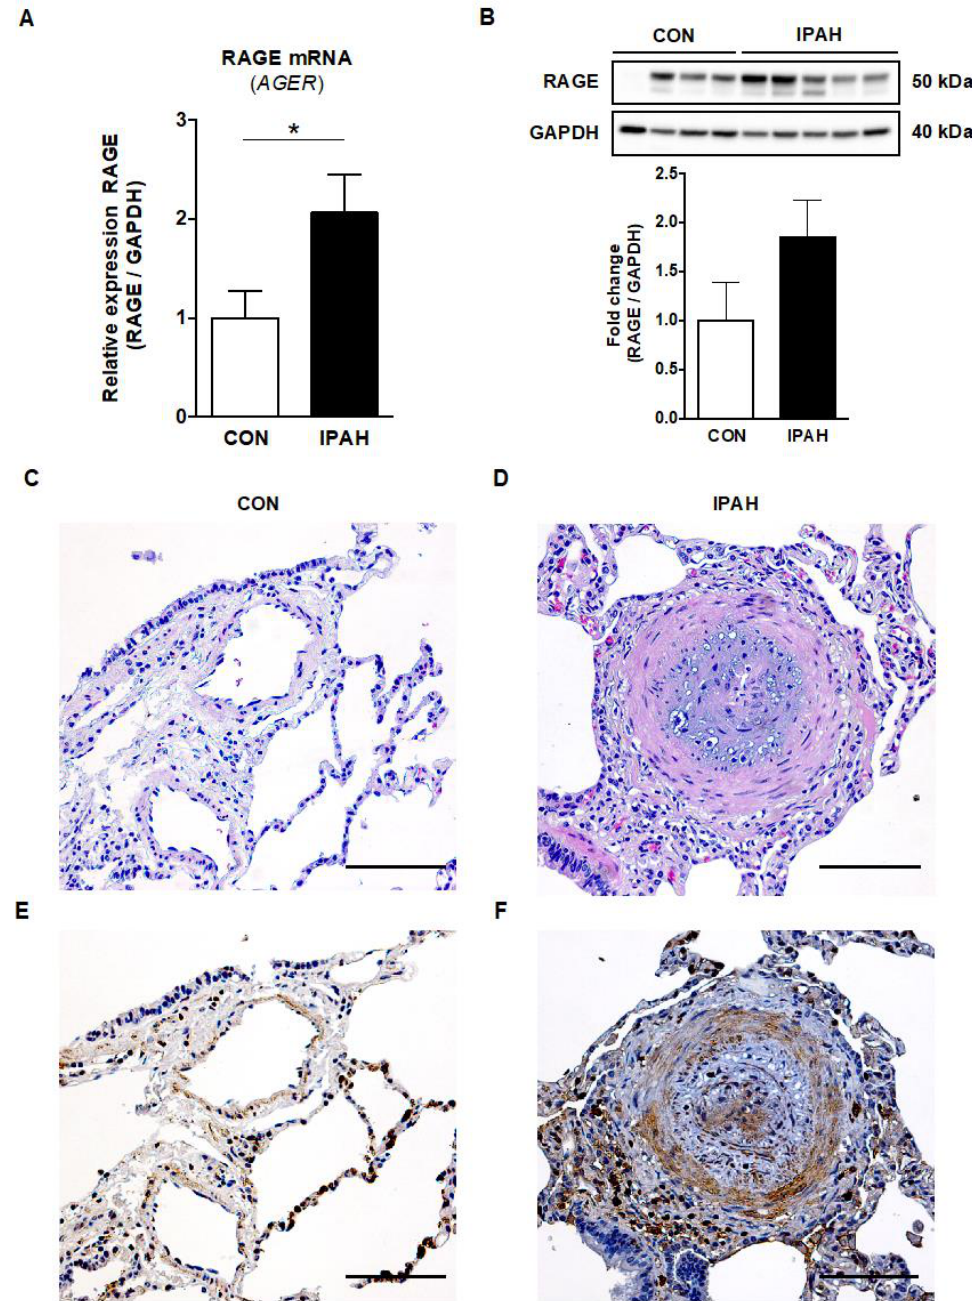
Figure 4. RAGE mRNA and protein expression, and immunohistochemistry in human lung tissues from end-stage IPAH patients versus controls. ( A ) The relative RAGE mRNA expression (AGER) normalized to GAPDH was significantly increased in end-stage IPAH patients (n = 7) vs. controls (CON; n = 9). ( B ) RAGE protein expression was elevated in whole human lung tissues of end-stage IPAH patients (n = 5) vs. controls (n = 4) measured by Western blot, but this difference did not reach statistical significance. Exposure time: 3.0 s. Values are presented as mean ± SEM. Statistical test: unpaired t -test with Welch’s correction, Mann–Whitney U. * p < 0.05. ( C ) Pulmonary artery of a female lung transplant donor lung (H&E staining; scale bar, 100 µm). ( D ) Obliterated pulmonary artery of an end-stage 42-year-old female IPAH patient (H&E staining; scale bar, 100 µm). ( E ) RAGE staining in a lung transplant donor lung of a female donor (scale bar, 100 µm). ( F ) The representative image of RAGE staining in a 42-year-old female IPAH patient shows the boosted RAGE expression in the intima and media (endothelial cells, smooth muscle cells, fibroblasts) of an obliterated distal pulmonary artery (concentric hypertrophic lesion). Heightened RAGE expression is also evident in perivascular cells in the outer adventitia, likely representing infiltrating proinflammatory cells, such as macrophages and lymphocytes (scale bar, 100 µm).